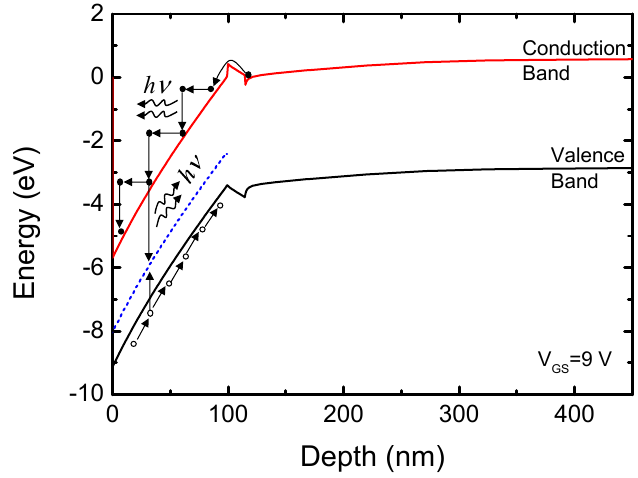
Figure 11. Schematic band diagram of an HEMT with p-GaN gate with V GS = 9 V showing the various processes responsible for EL.